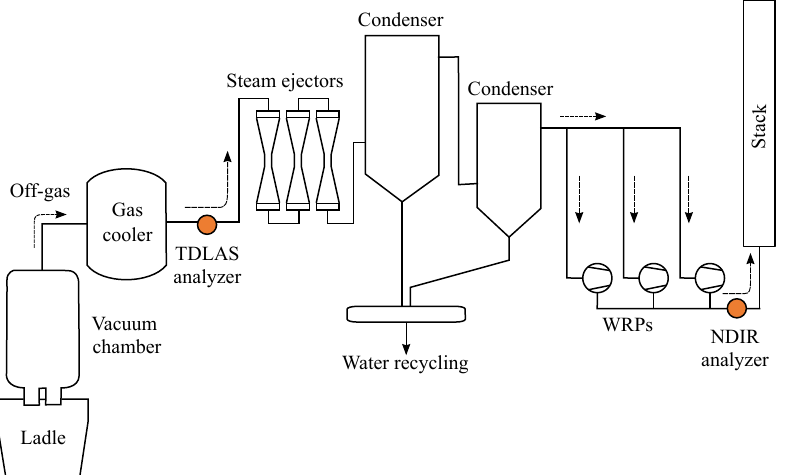
Figure 1. Schematic diagram of the RH vacuum degasser.It shows the installation locations of the TDLAS and NDIR analyzers (filled